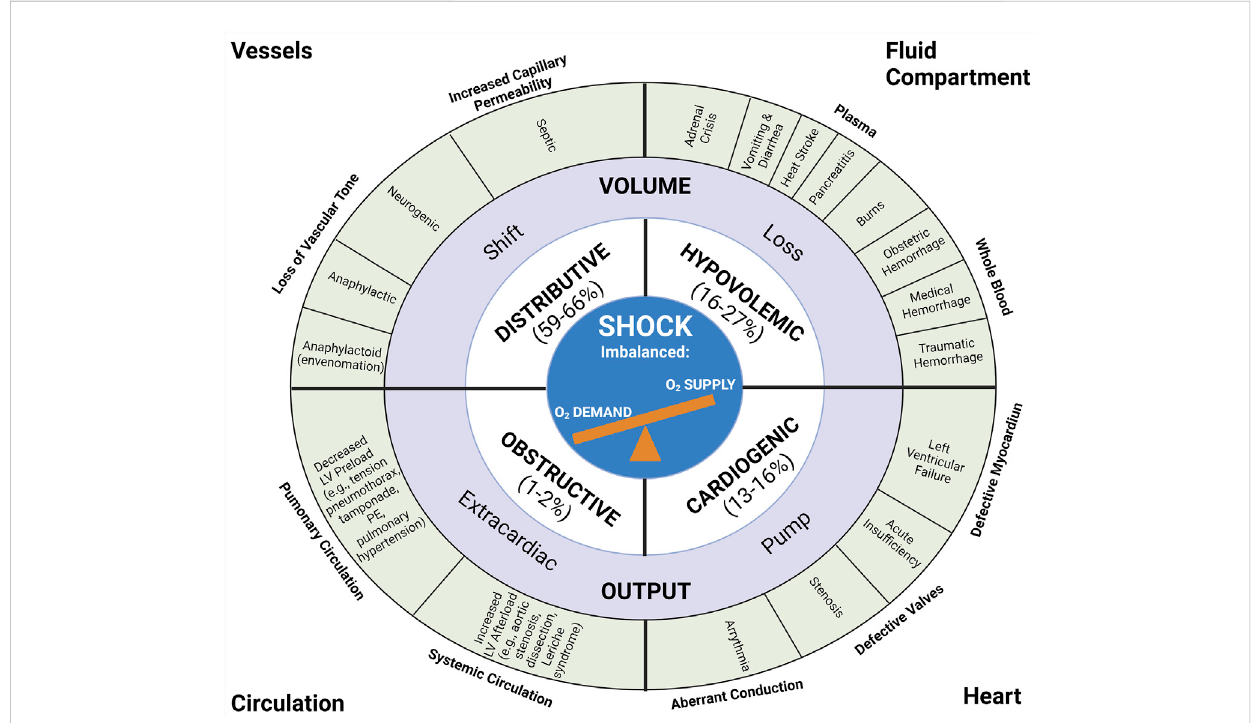
FIGURE 1 Anatomic and Pathophysiologic Categorization of Shock with Relative Frequency of Each Type. The traditional classi fi cation of shock includes four main categories: distributive, hypovolemic, obstructive, and cardiogenic shock. The estimated relative frequency of each of the four subcategories are listed with pathophysiologic etiologies de fi ned around the periphery of the diagram (Vincent and De Backer, 2013; Standl et al., 2018). Recreated with permission from (Standl et al., 2018). Created with